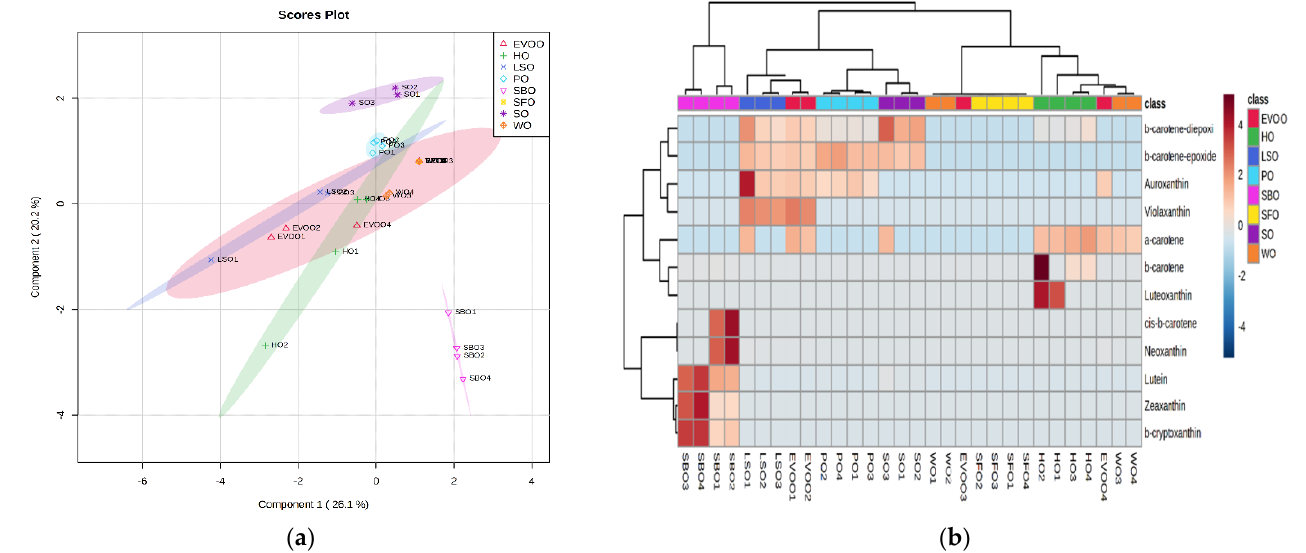
Figure 3. ( a ) PLSDA score plot for the discriminatory analysis of the eight classes of oils, considering their carotenoid contents. ( b ) Heatmap representing the Euclidian distance using Ward algorithm to identify the similarities between individual oils.